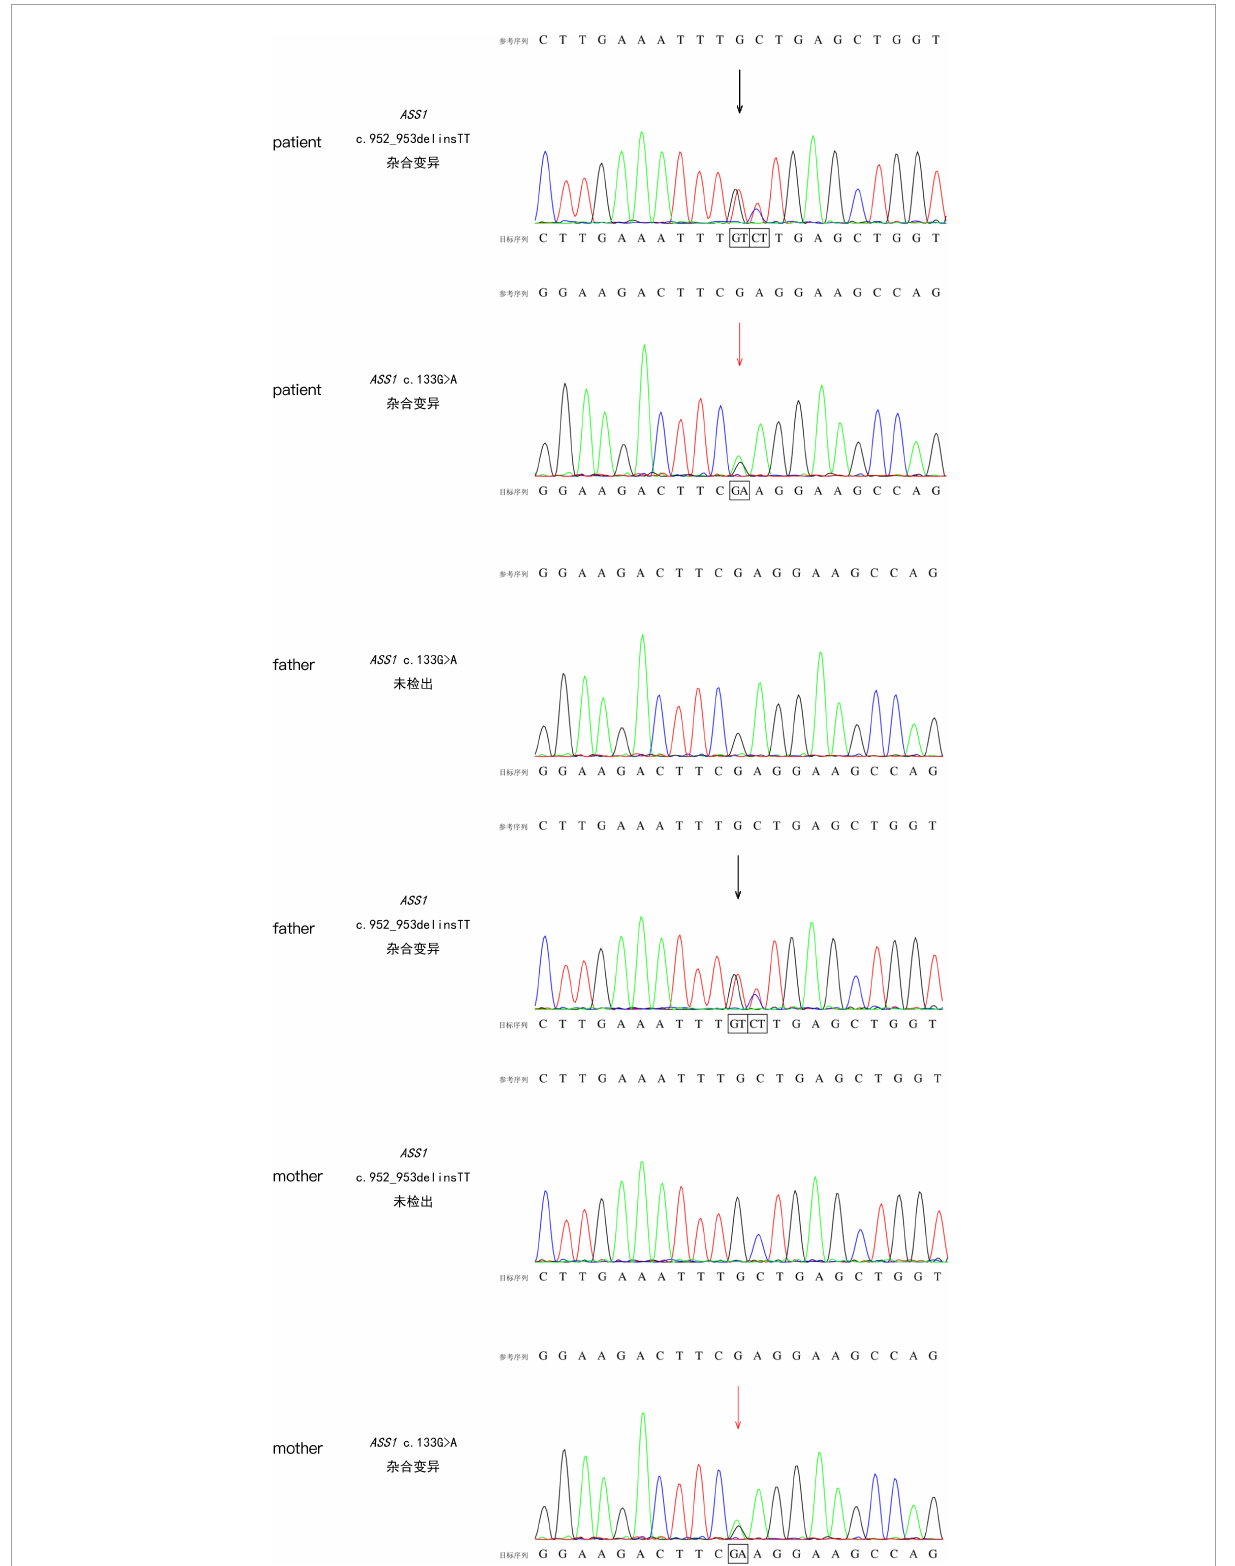
FIGURE2 Sanger sequence of ASS1 (c.952_953 delinsTT and c.133G > A) from patient 2 and her parents.